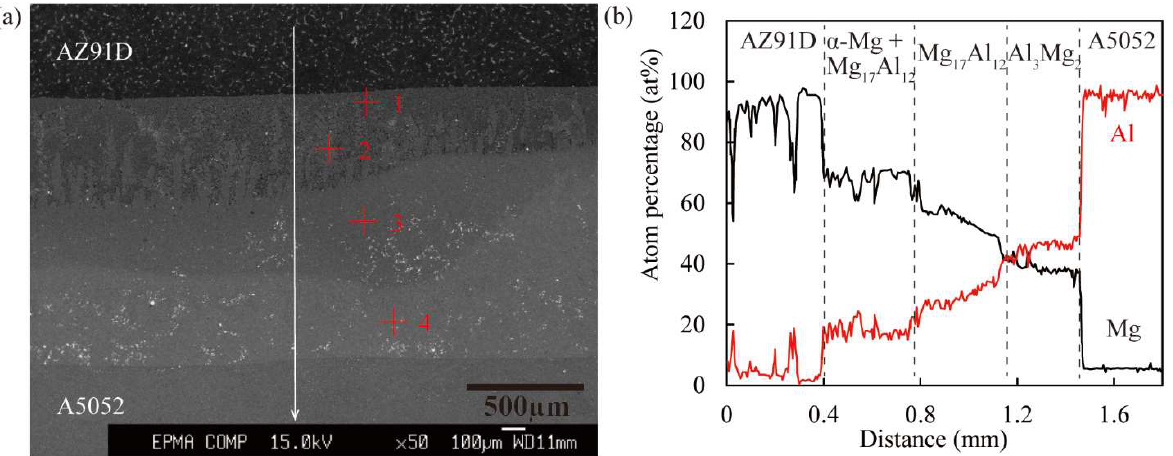
Figure 10. Microstructure and EDS analysis results on the bonding interface of the Mg/Al clad strips: ( a ) SEM image; ( b ) EDS line scan result corresponding to ( a ). Table 5. Results of EDS point scan analysis at different positions of the interface corresponding to Figure 10a.